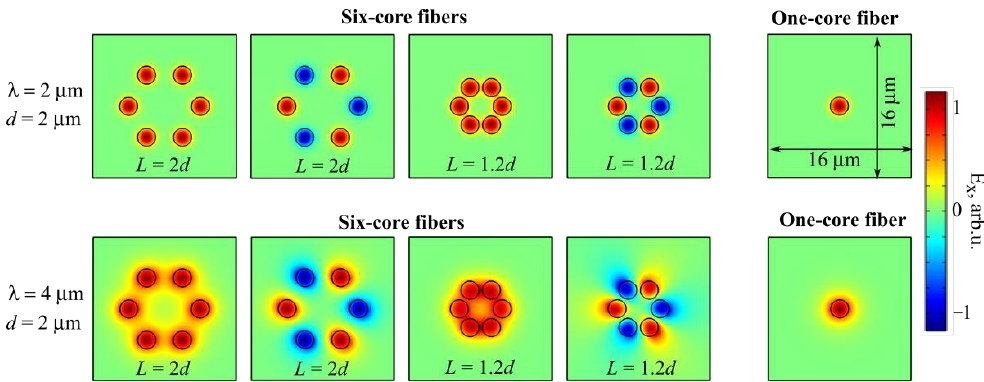
Figure 9. The fields of in-phase and out-of-phase supermodes for six-core fibers with different L / d ratios and the fundamental mode field of a one-core fiber calculated at a wavelength of 2 μm (upper row) and a wavelength of 4 µ m (lower row). All results are obtained for TWL/GTZN core/cladding glasses, d = 2 μm.